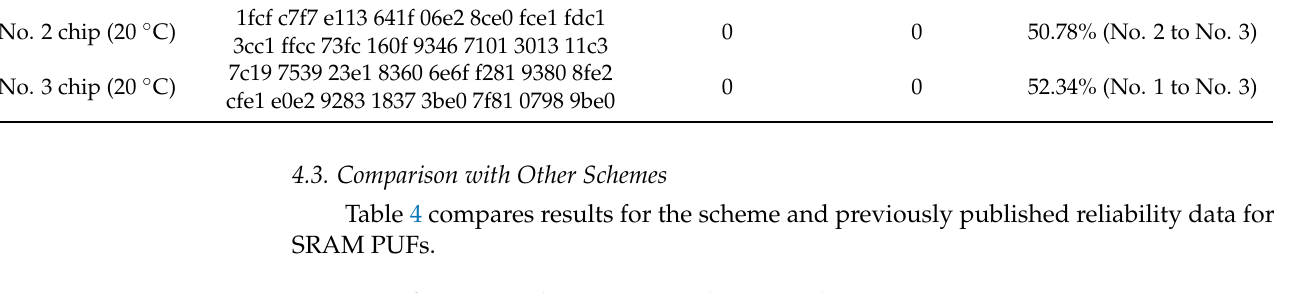
Table 4. Performance and comparison with prior